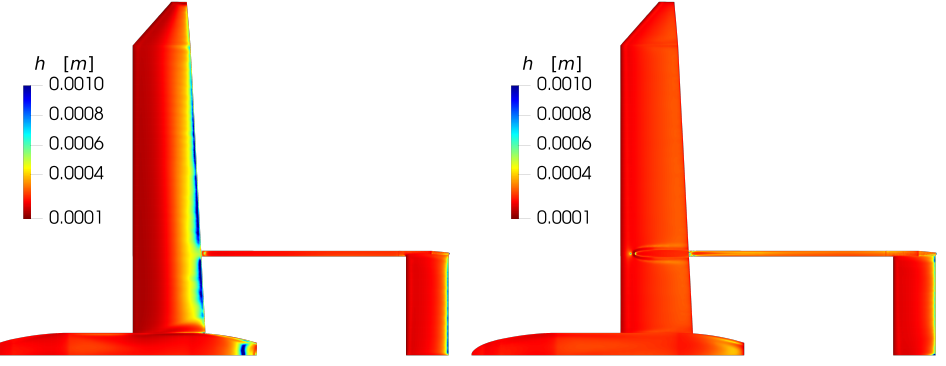
Figure 12. Spatial distribution of the computed optimal riblets height in physical units, for symmetric V groove riblets. Left : upper part of the aircraft in cruise conditions; right : lower